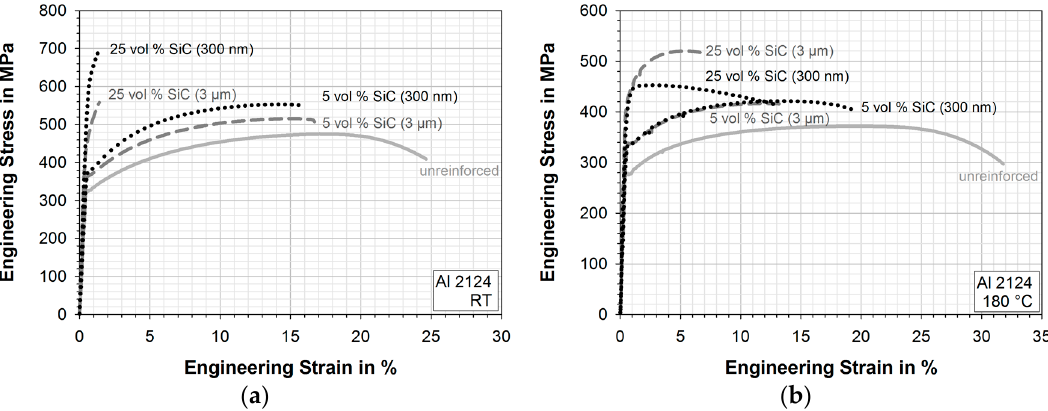
Figure 4. Tensile behavior of the unreinforced and reinforced 2124 aluminum alloy ( a ) at room temperature and ( b ) at 180 °C. Figure shows one representative curve for each condition. Table 2. Mechanical properties determined by tensile testing of the unreinforced and reinforced 2124 aluminum alloy. The deviation is given in absolute values.